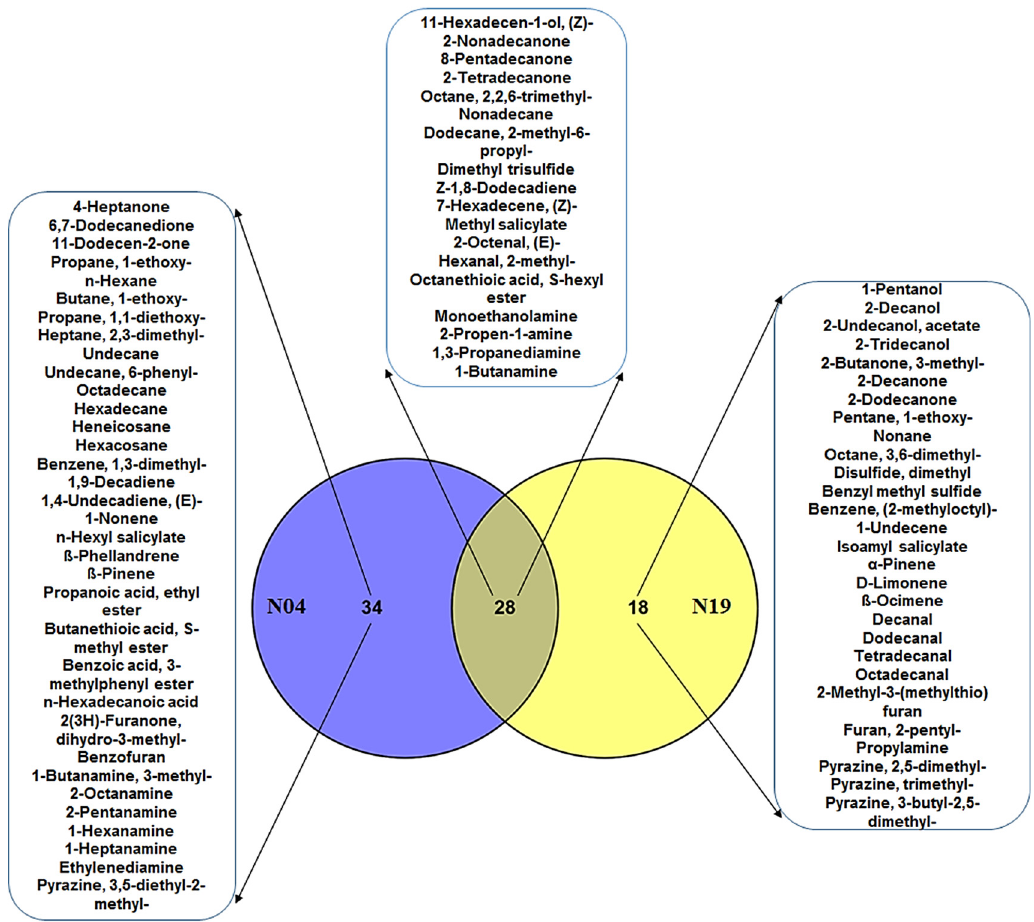
Figure 3. Venn diagram comparing the volatile organic compounds of the two Pseudomonas strains. The diagram shows shared and distinct volatile organic compounds from Pseudomonas koreensis (N19) and Pseudomonas fluorescens (N04), as indicated by the numbers in the intersections and ellipses, respectively.